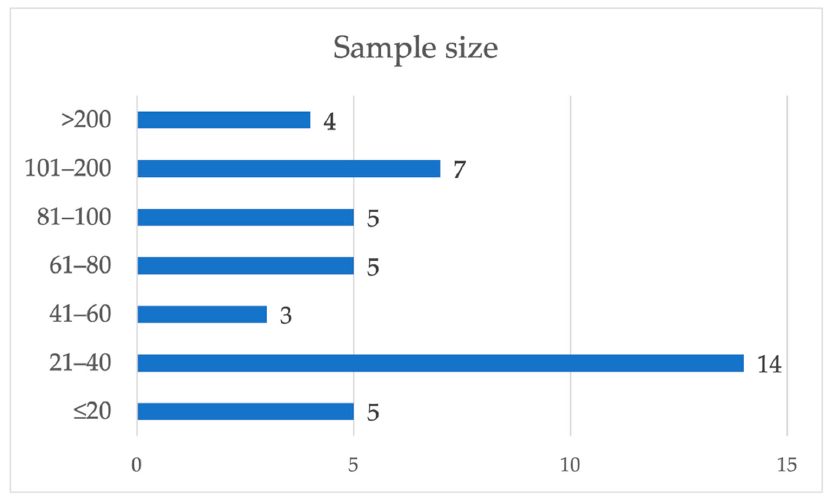
Figure 3. Sample size in the reviewed papers.